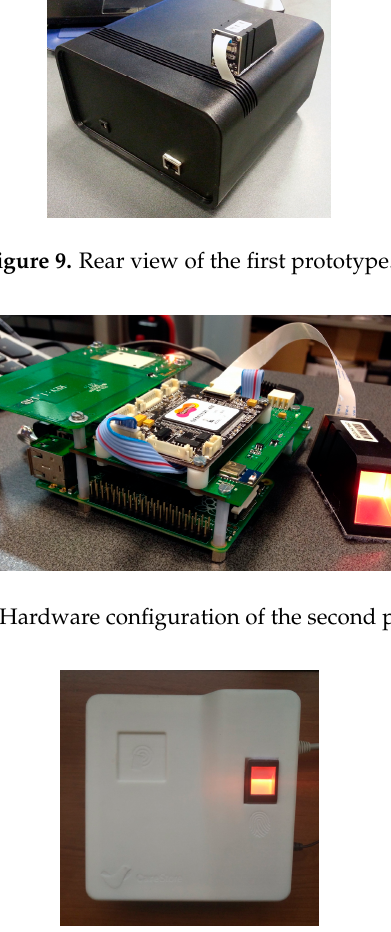
Figure 12. Side view of the second prototype.